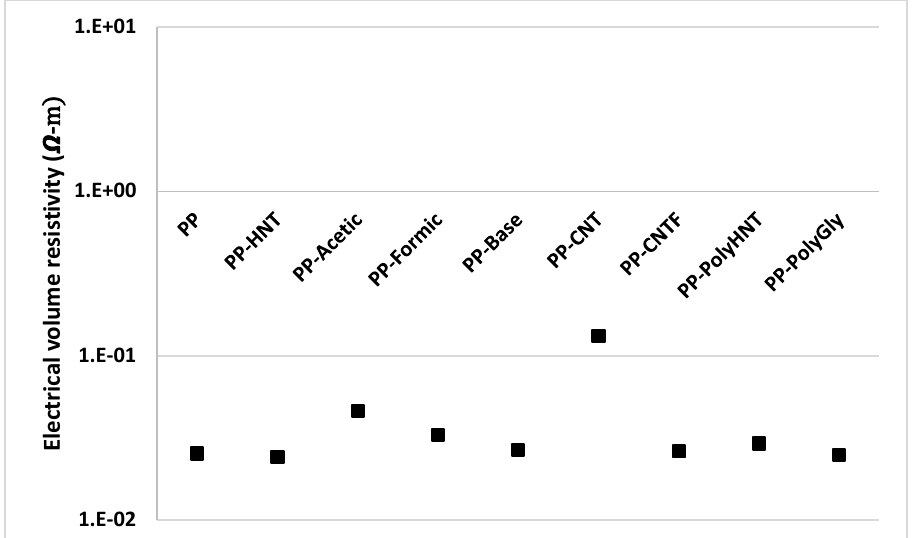
Figure 12. Electrical volume resistivity for all